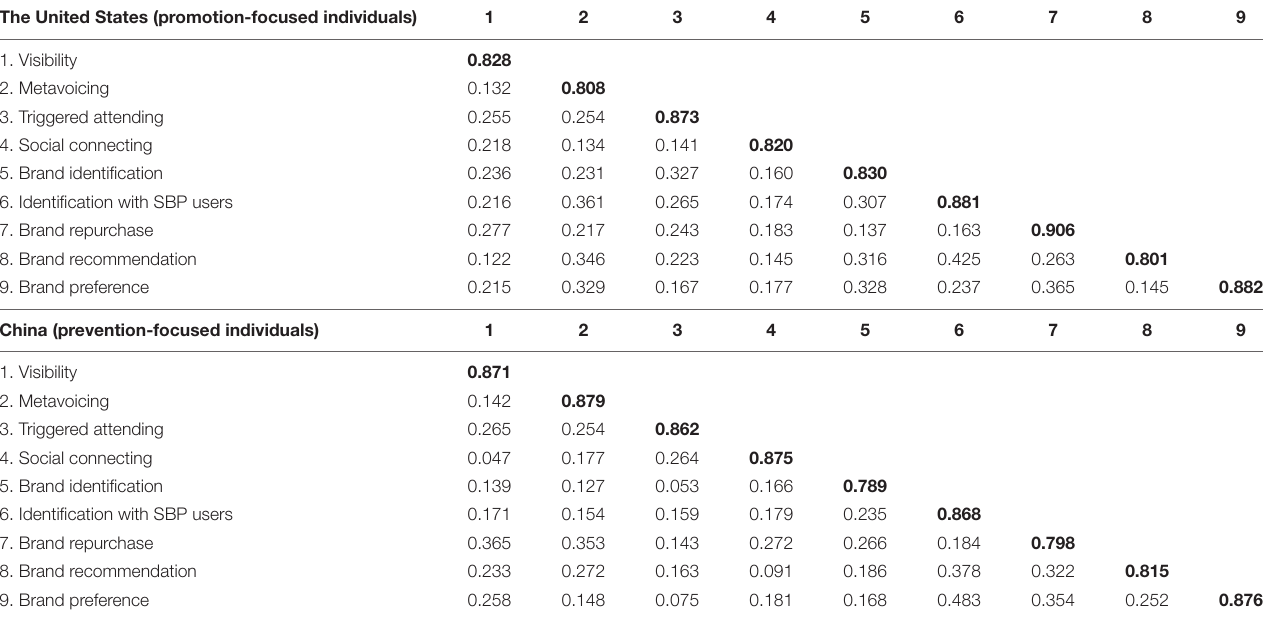
TABLE 5 | Correlations between the constructs and the square roots of the AVEs (on the diagonal). The United States (promotion-focused